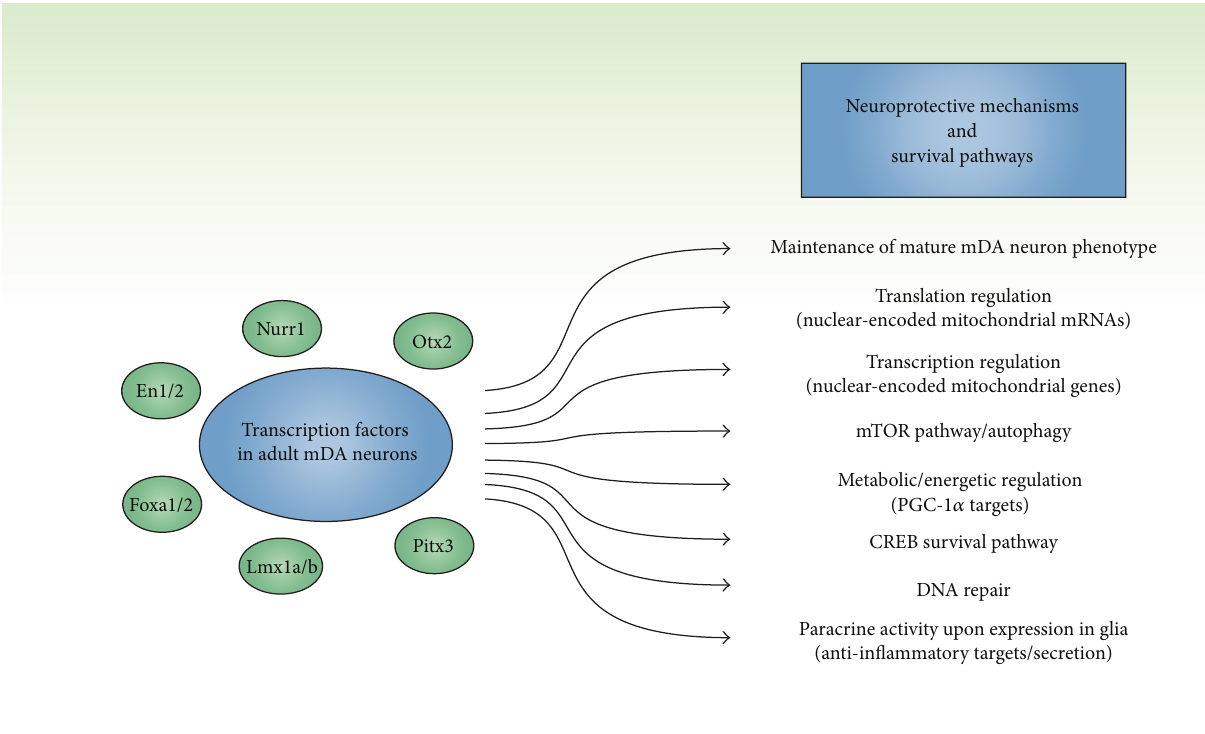
Figure 1: Multiple mechanisms and signalling pathways engaged by transcription factors for neuroprotection of adult mDA neurons.